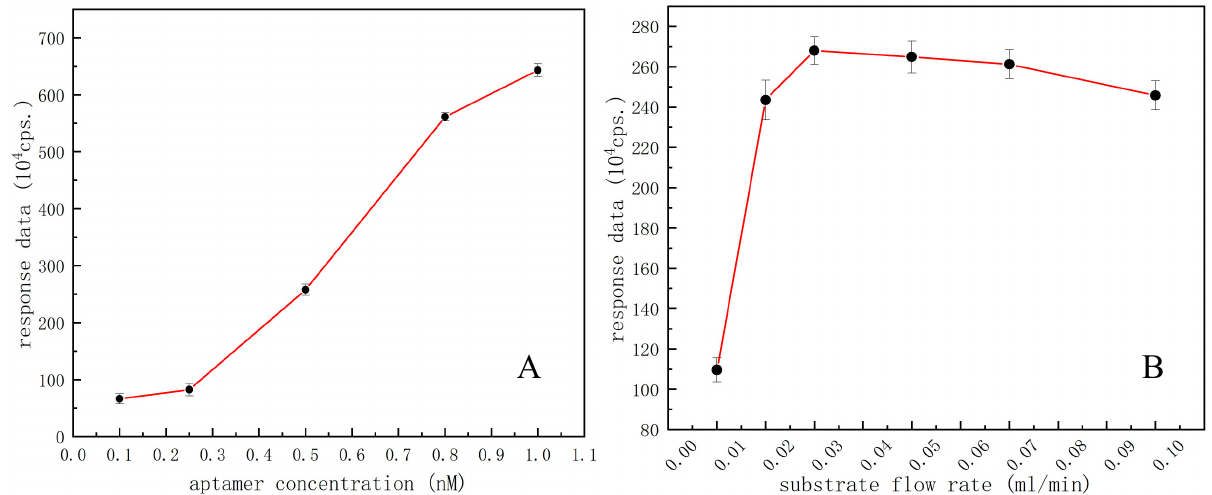
Figure 5. ( A ) Optimization of the aptamer concentration with datapoints of black dots; ( B ) Optimization of the substrate flow rate with datapoints of black dots.